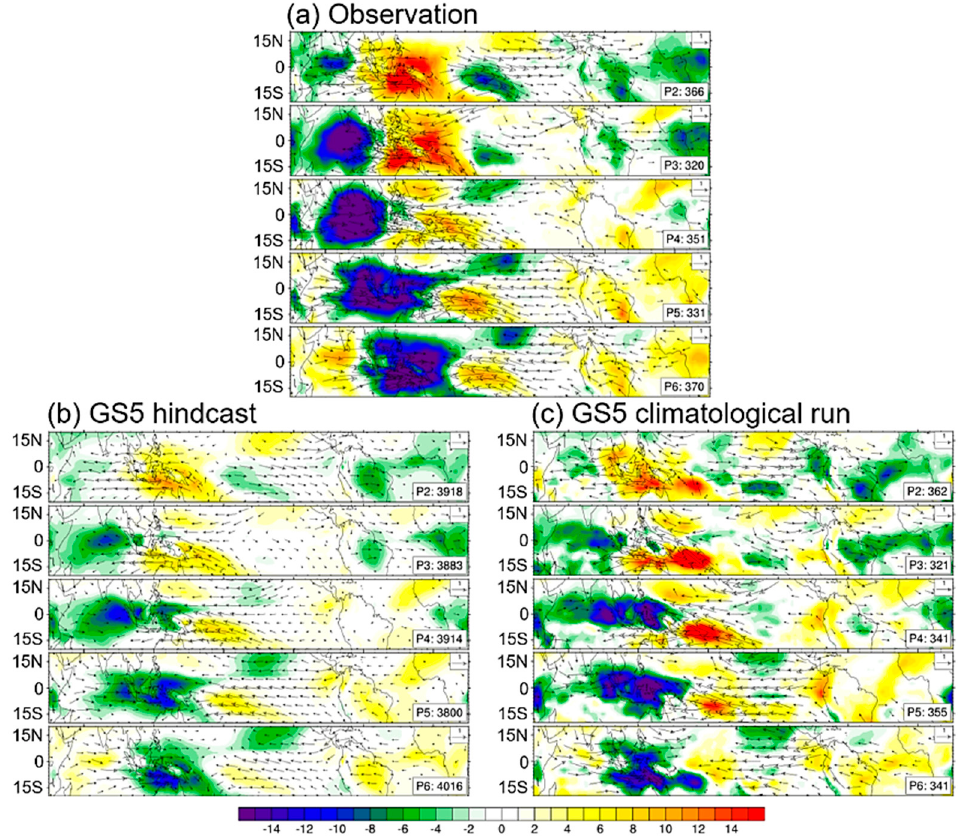
Figure 3. Composite of 20–70-day outgoing longwave radiation (OLR, color) and surface wind anomalies (vectors) based on a function of the MJO phase during boreal winter (November–April). ( a ) observation, ( b ) GS5 hindcast data, and ( c ) GS5 climatological run. The zonal wind anomalies with statistically 99% significance are drawn. The numbers of each panel represent the number of days used for composite for each phase. The number of days used for the observation and the GS5 climatological run is 4500 days (25y × 180 days), whereas the number for the GS5 hindcast data is 56,000 days (25y × 180 × 4 (hindcast dataset number per month) × 6 (November–April).